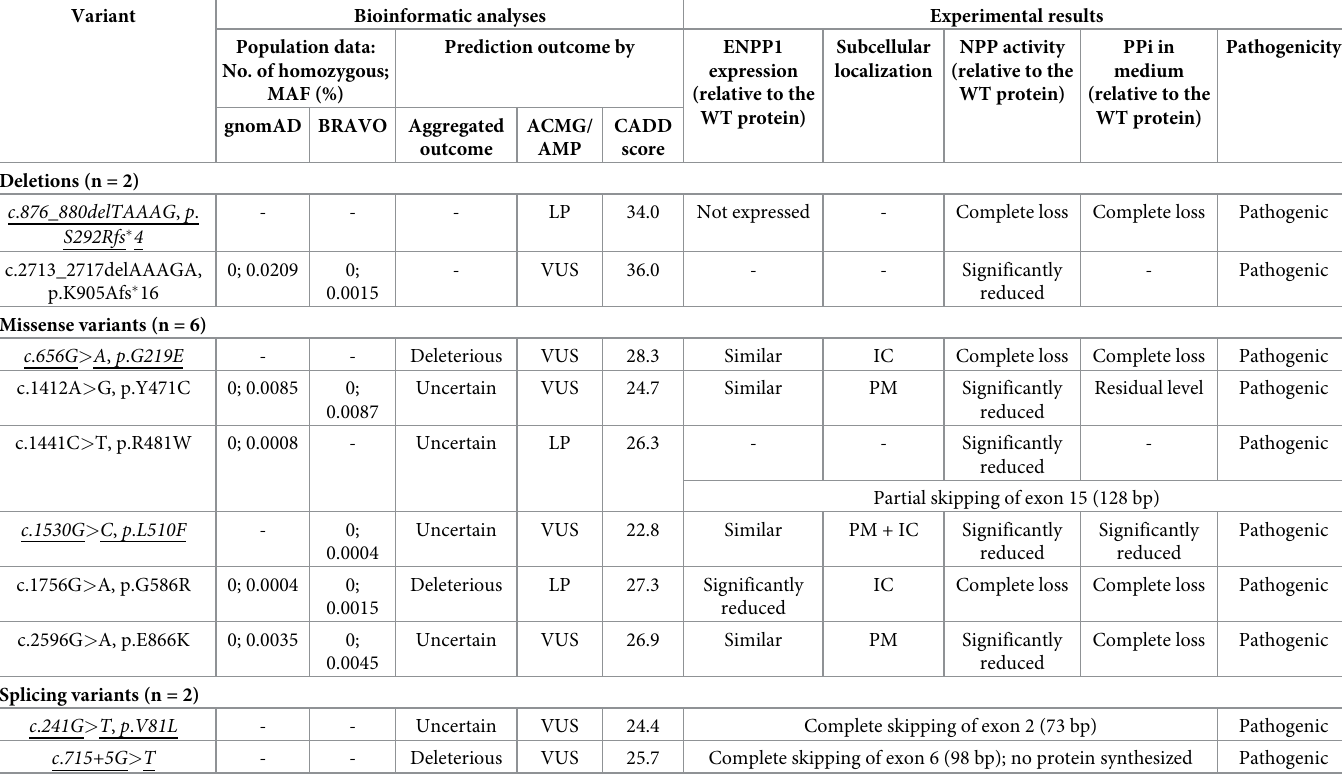
Table 2. In silico predictions of ENPP1 variants and comparison with experimental results. The five previously unreported variants in ENPP1 were italic and underlined. Variant Bioinformatic